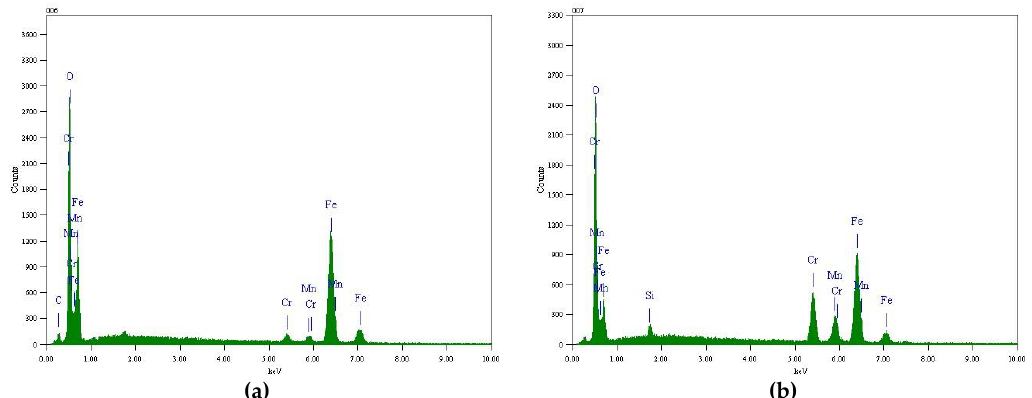
Figure 6. EDS analysis of the oxides formed on TP347H at 700 °C after 168 h. ( a ) No.03 in Figure 5; ( b ) No.04 in Figure 5.